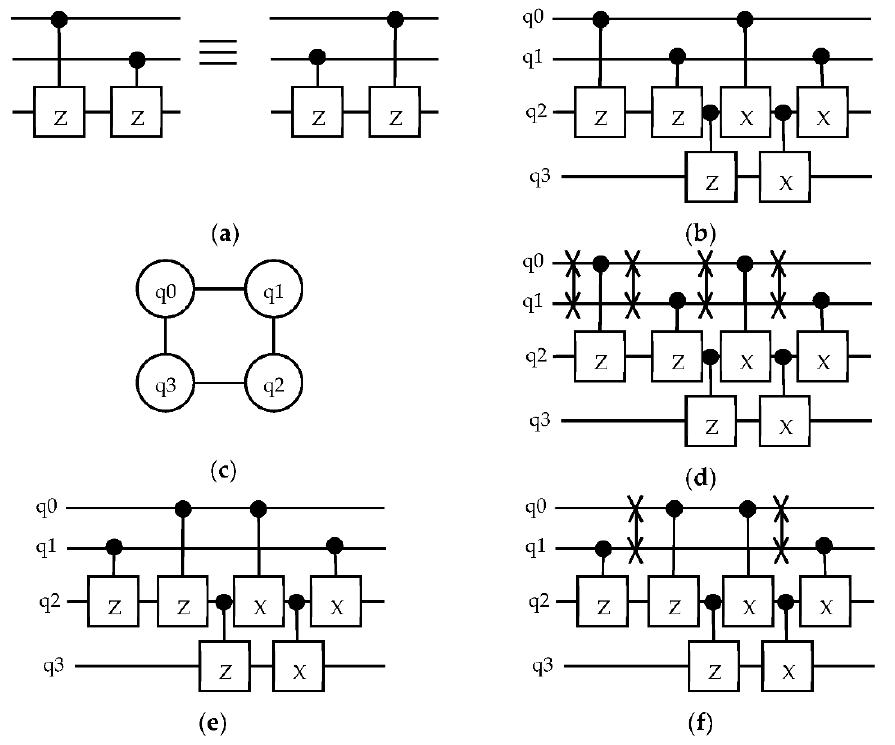
Figure 3. ( a ) A quantum transformation rule, ( b ) a quantum circuit, ( c ) initial locations of qubits, ( d ) the original circuit including SWAP gates, ( e ) the transformed circuit, and ( f ) the transformed circuit including SWAP gates.